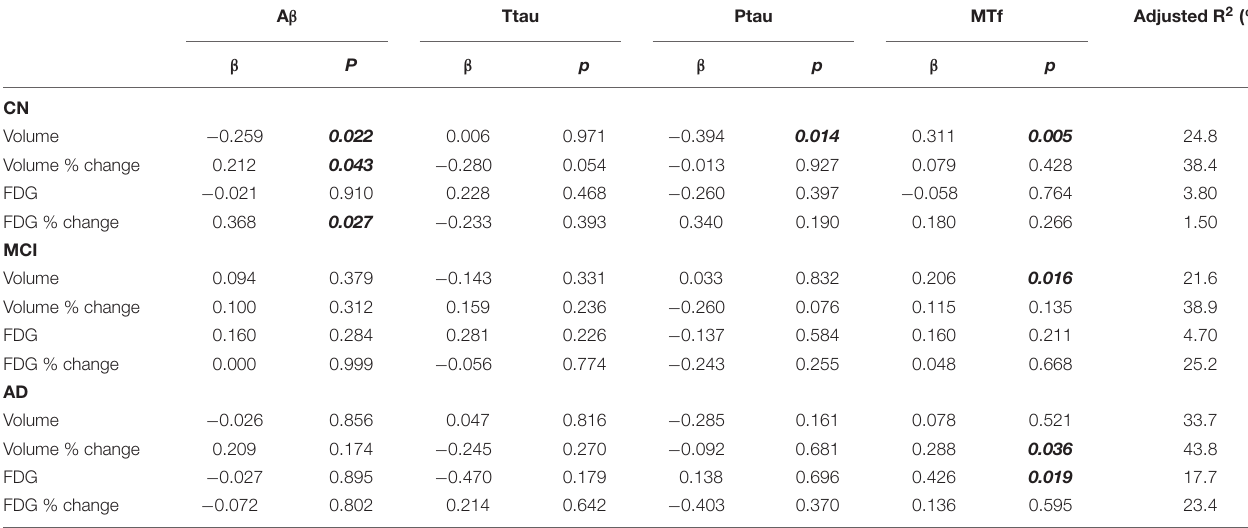
TABLE 4 | Modeling the association of CSF A β , total tau (ttau), phosphorylated tau (ptau), and melanotransferrin (MTf) with neuroimaging measures of the hippocampus in cognitively normal (CN), mild cognitive impairment (MCI) or Alzheimer’s disease (AD) ( Supplementary Figure 3